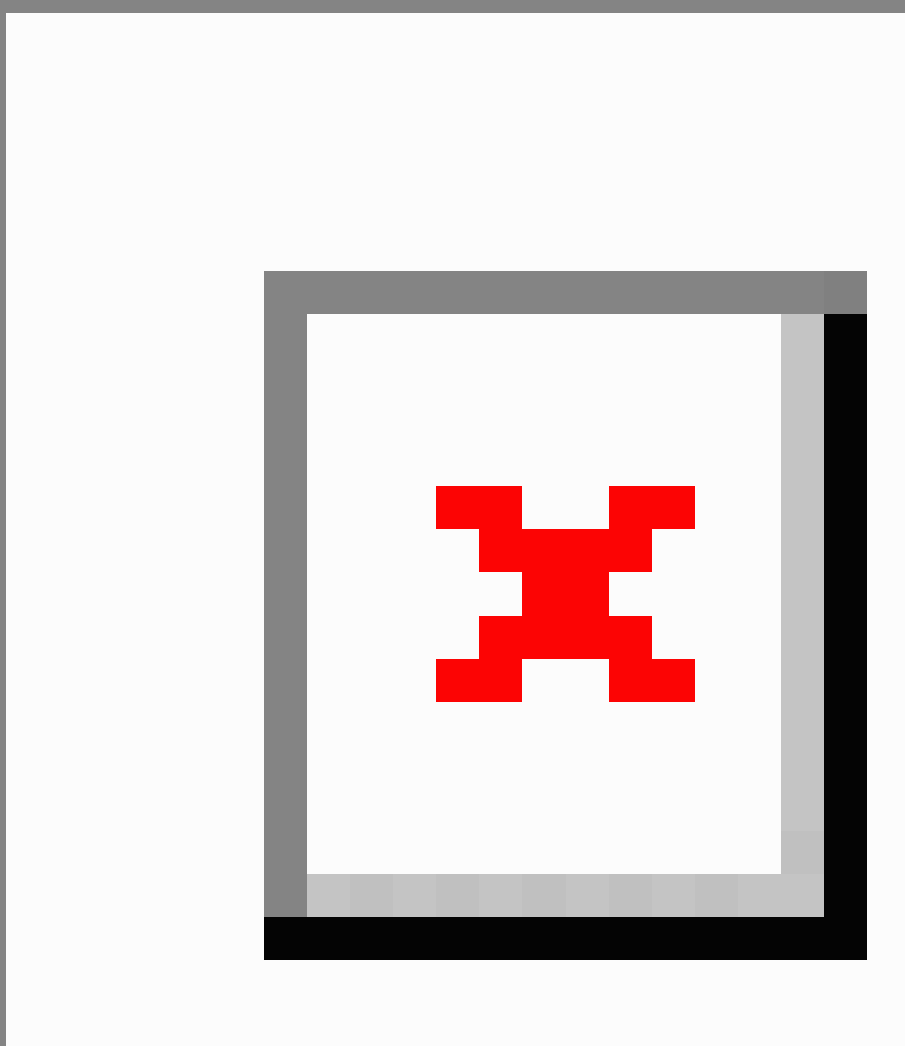
Figure 7. Screenshot of combination mode feedback